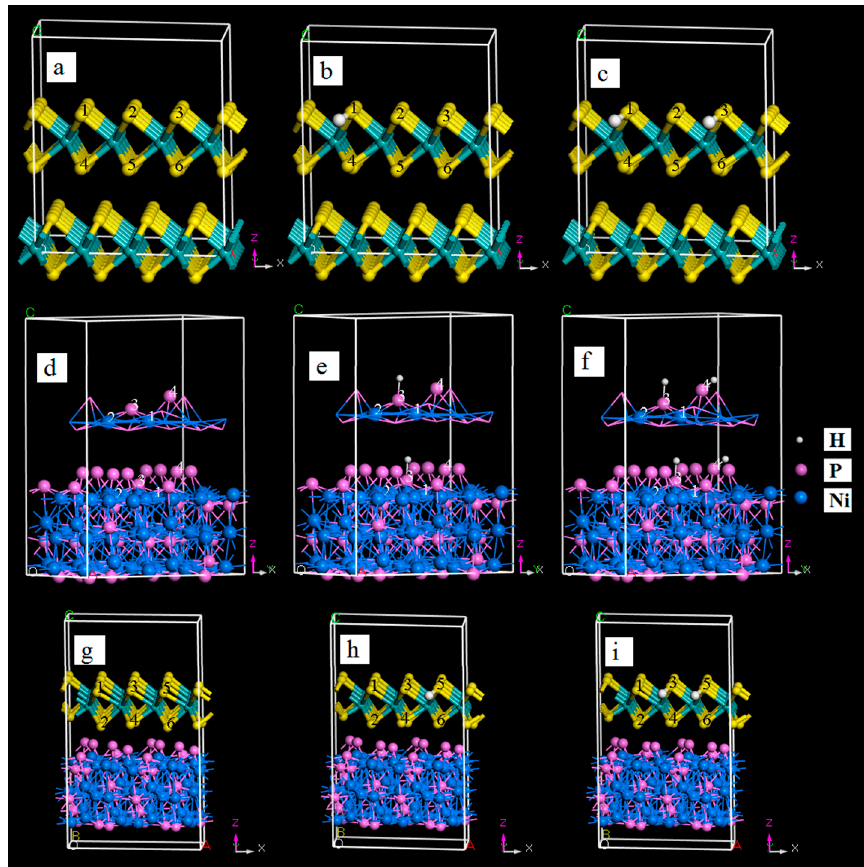
Figure 9. The optimized structures of MoS 2 , Ni 2 P, and MoS 2 /Ni 2 P three catalysts without hydrogen adsorption, as well as those with one and two adsorbed hydrogen atoms. ( a ) MoS 2 ; ( b ) MoS 2 -1H; ( c ) MoS 2 -2H; ( d ) Ni 2 P; ( e ) Ni 2 P-1H; ( f ) Ni 2 P-2H; ( g ) MoS 2 /Ni 2 P; ( h ) MoS 2 /Ni 2 P-1H; and ( i ) MoS 2 /Ni 2 P-2H.